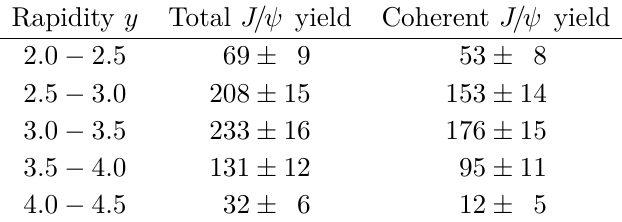
Table 1 . Total and coherent J/ψ yields after the invariant mass and the transverse momentum fits, in J/ψ rapidity